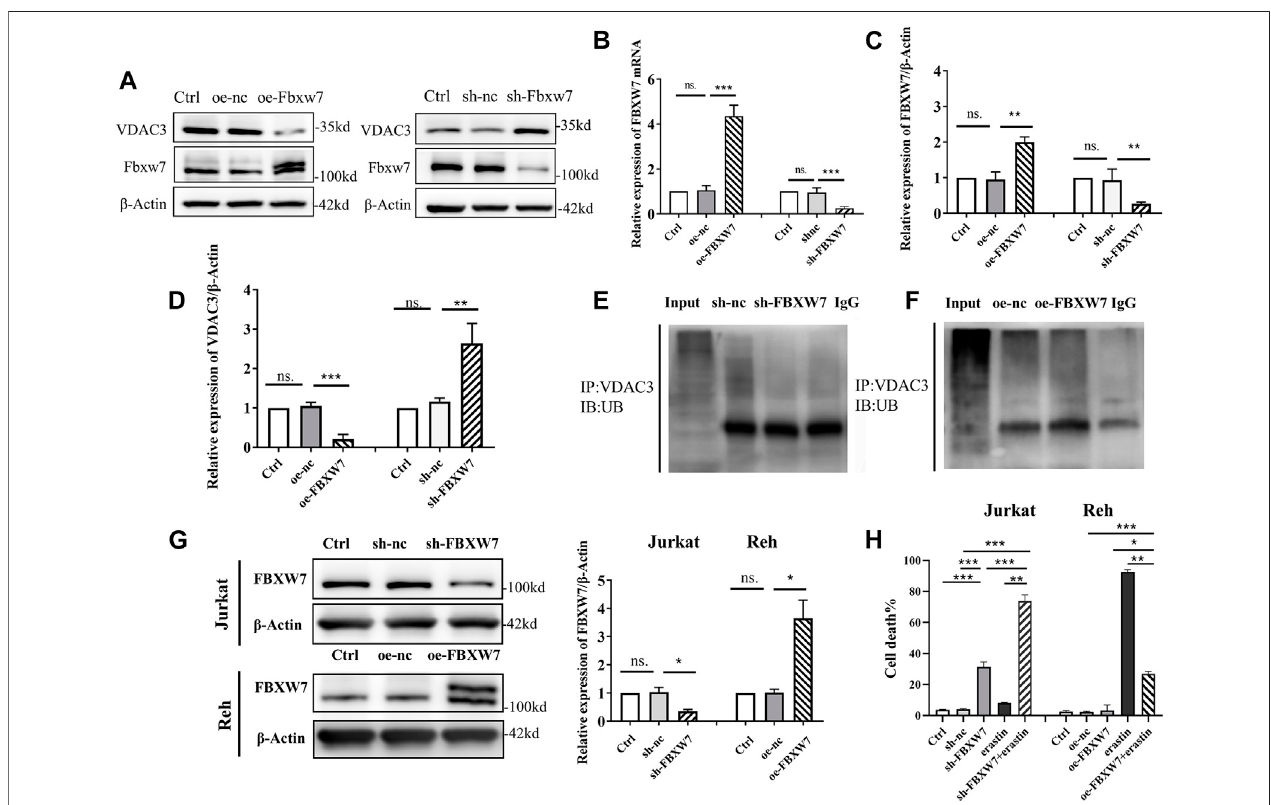
FIGURE4| FBXW7affectedtheubiquitinationlevelofVDAC3andthesensitivityofALLcellstoerastin. (A) Con fi rmationofthetransfectionef fi ciencyofVDAC3and FBXW7 proteins in 293T cells with FBXW7 overexpression/RNAi lentiviral vector by IB. The expression of β -actin was examined as a control. (B) Con fi rmation of transfection ef fi ciency of VDAC3 and FBXW7 mRNA expression in 293T cells with FBXW7 overexpression/RNAi lentiviral vector by qRT-PCR. (C) Histogram of the FBXW7 protein expression with FBXW7 overexpression/RNAi lentiviral vector transfection. (D) Histogram of the relative expression levels of VDAC3 following FBXW7 overexpression or knockdown. (E) Cells with FBXW7 silencing were treated with 10 μ mol/l MG132 for 6 h and whole cell lysates were subjected to immunoprecipitation with either VDAC3 antibody or normal IgG antibody. (F) Cells overexpressing FBXW7 were treated with 10 μ mol/l MG132 for 6 h and whole cell lysates were subjected to immunoprecipitation with either VDAC3 antibody or normal IgG antibody. A ubiquitin antibody was used for IB. (G) Con fi rmation of the transfection ef fi ciency of FBXW7 in ALL cells with FBXW7 overexpression/RNAi lentiviral vector by IB. Left, expression levels of FBXW7; right, histogram of results. (H) Con fi rmation of the transfection ef fi ciency of VDAC3 and FBXW7 in Reh cells with the FBXW7 overexpression lentiviral vector by IB. The expression of β -actin was examined asacontrol. (H) Trypan blue stainingdetection ofALL cell death following different treatments.Left, percentagesoftrypanblue-positive cells; right, histogram of results. p * < 0.05, ** p < 0.01, *** p < 0.001, ns. indicates no statistical signi fi cance.